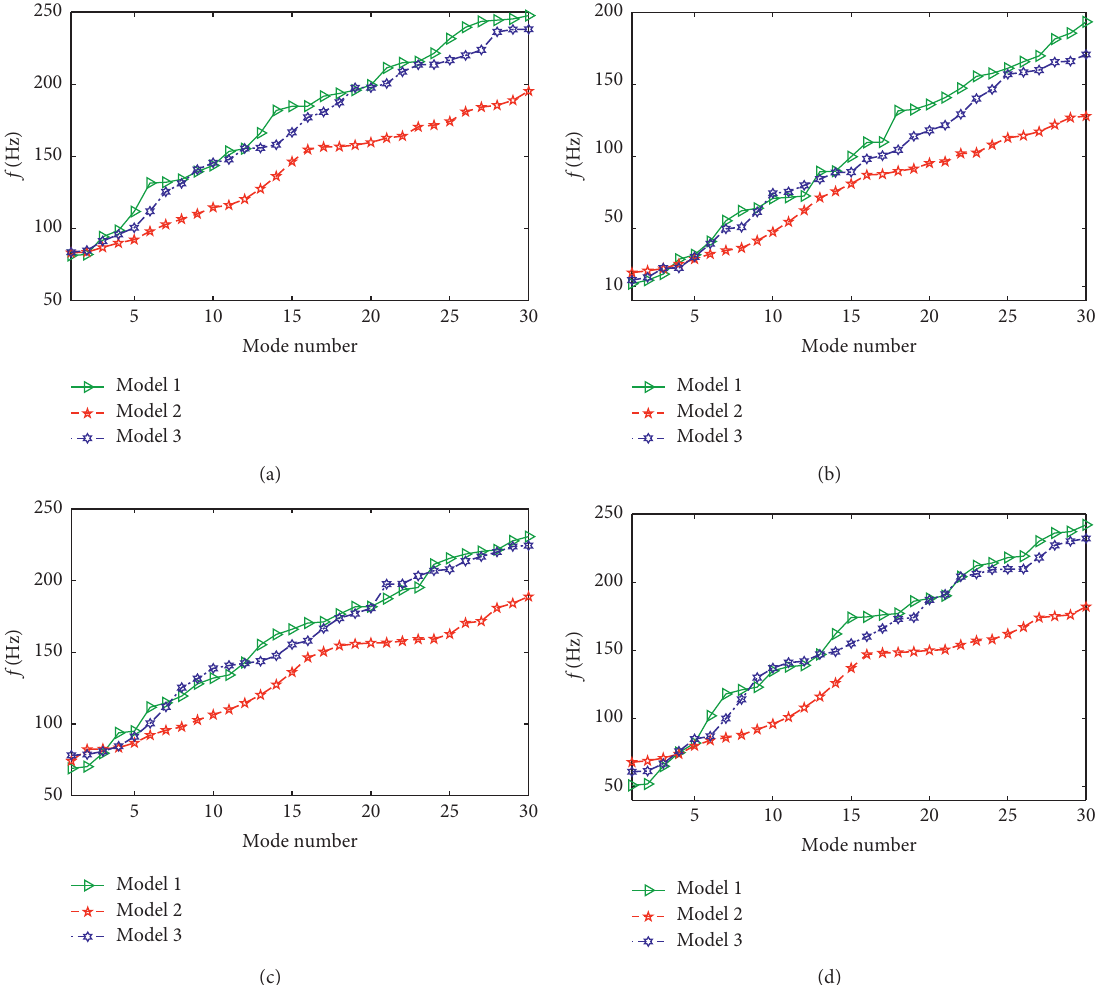
Figure 12: First 30 orders of frequencies of stepped joined conical shells under different boundary